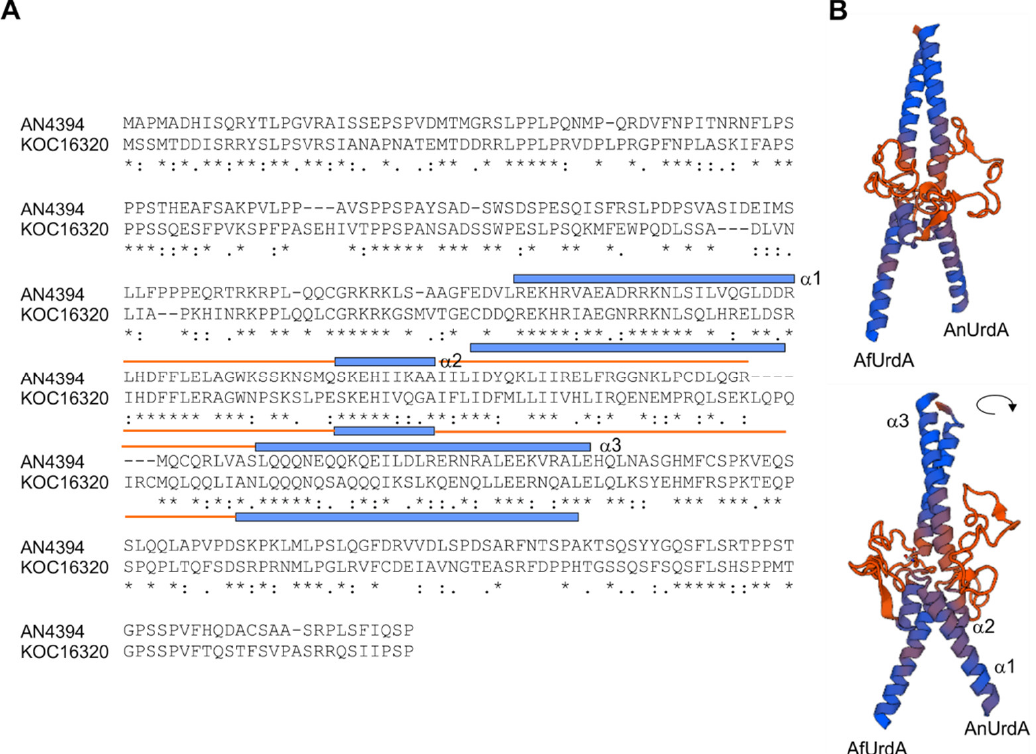
Figure 2. 3D modeling of UrdA sequence. ( A ) Sequence alignment of AN4394/AnUrdA and its A. flavus ortholog KOC16320/AfUrdA. The position and extension of the three predicted α -helices of the putative HLH transcriptional regulatory domain are indicated by blue lines while orange lines delimit the extension of the loops. ( B ) Swiss-model images of a hypothetic dimer formed by the HLH domains of AnUrdA and AfUrdA. Helices are shown in blue and loops in orange.